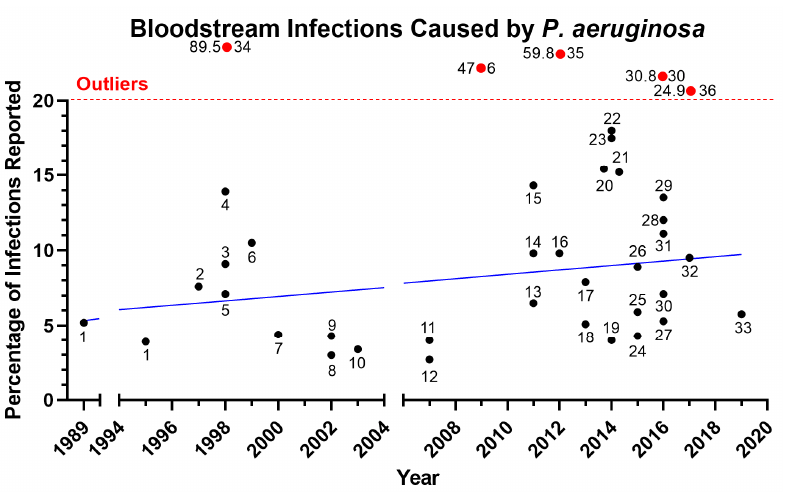
Figure 3. Rates for bloodstream infections caused by P. aeruginosa in hospitalized patients over the past 3 decades (1989–2019). Hospital-acquired infections included bloodstream infections and catheter-associated bloodstream infections, catheter-associated urinary tract infection, surgical site infections and burn wound infections, and hospital-associated and ventilator-associated pneumonia; although not every article reported every category, most included at least three. Each circle represents the rate reported in the study, and the year corresponds to the last collection date of the data. The solid blue line represents the linear regression of the infection rate over the years excluding outliers, which are shown above the dotted red line. The numbers associated with the black circles indicate reference numbers; the numbers to the left of the red circles are the percentages, and those to the right are the reference numbers. References: 1. [5], 2. [39], 3. [22], 4. [19], 5. [40], 6. [41], 7. [42], 8. [43], 9.